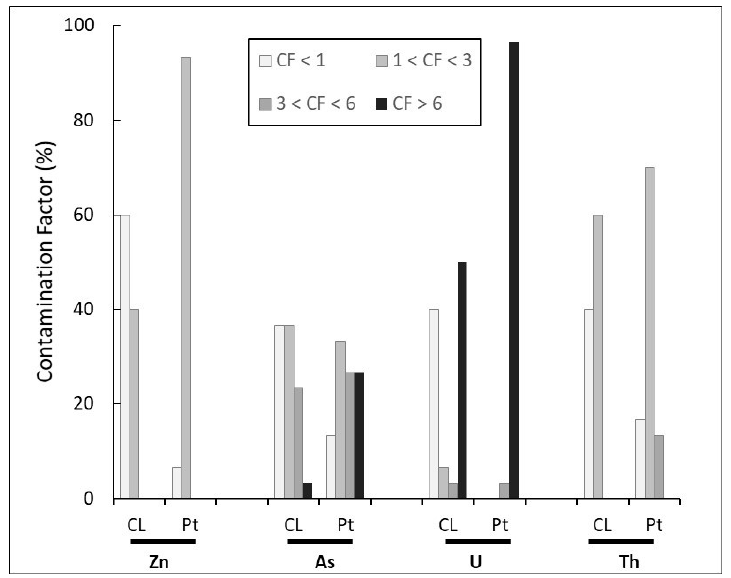
Figure 4. Comparison of contamination factor classes percentage for Zn, As, U, and Th using Canto Lagar background values (CL) and Portuguese background values (Pt).